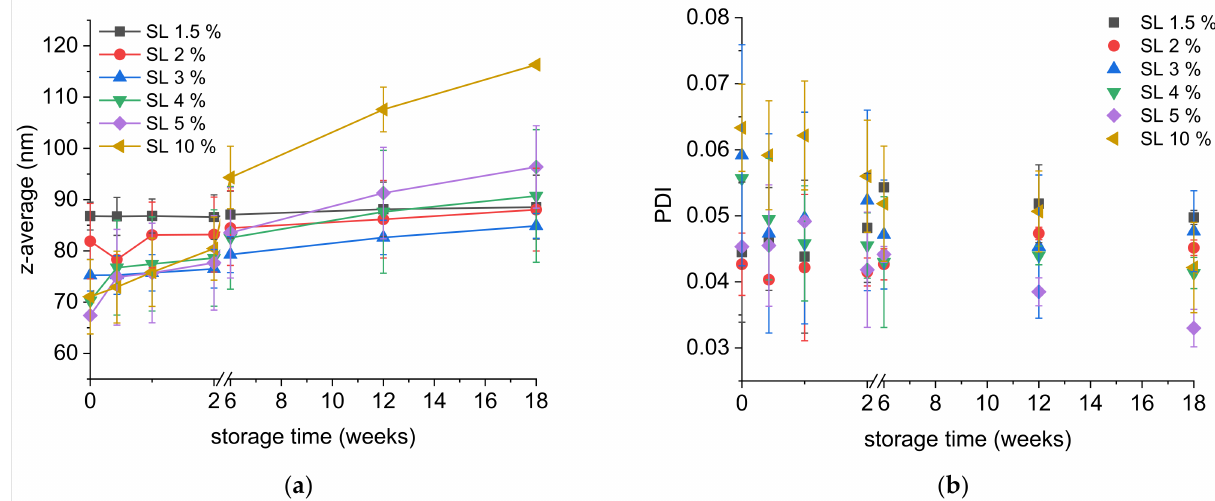
Figure 4. ( a ) Z-average and ( b ) PDI of MCT (10%) nanoemulsions stabilised with 1.5% to 10% SL plotted against the storage time. Nanoemulsions were produced by PME with Anodisc ™ 20 nm membranes (0.2 mL/s). Mean of 2 independent experiments ( n = 2) ± standard